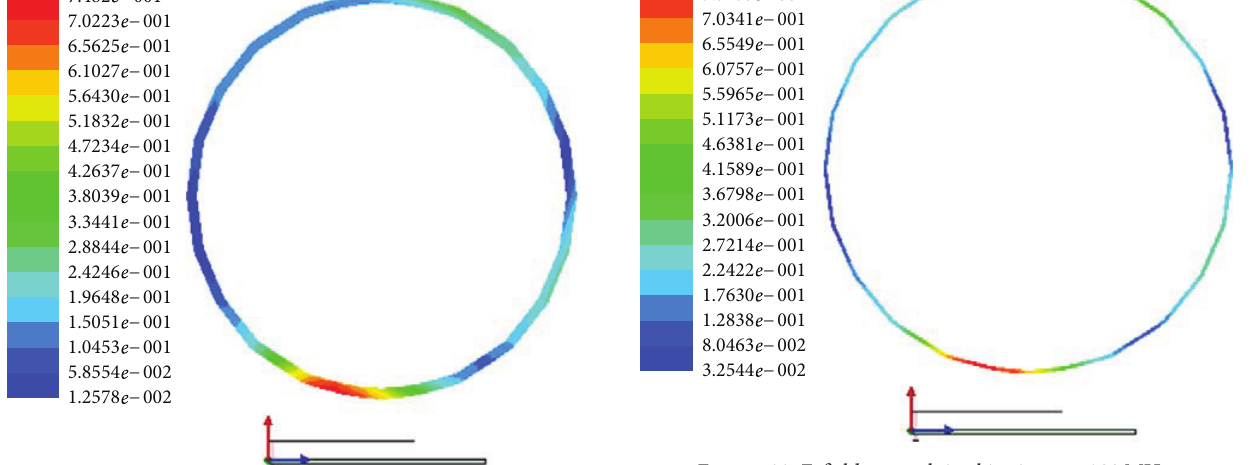
F 22: �-�eld strength in skin tissue at